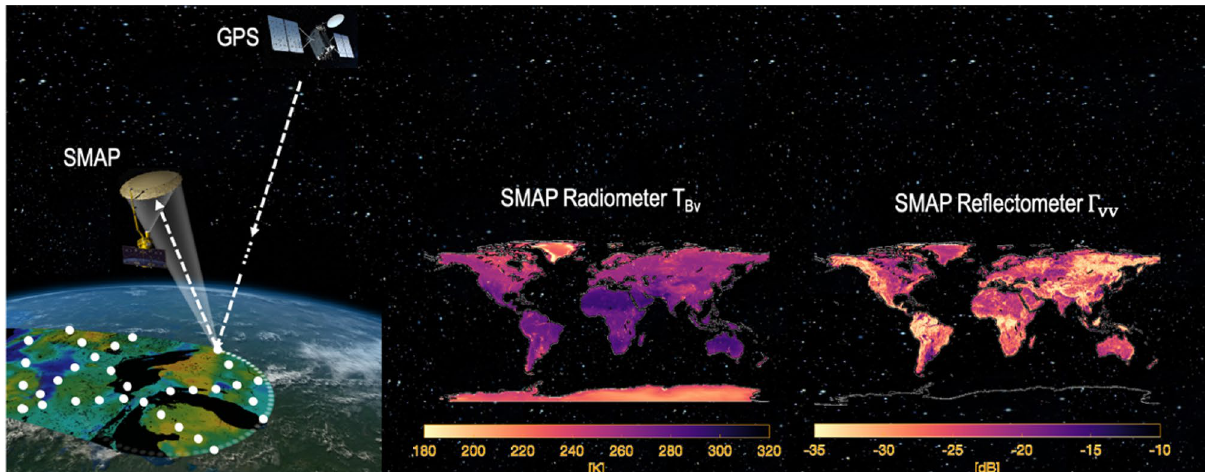
Figure 2. SMAP-Reflectometry—Conceptual sketch of SMAP radiometer and SMAP-Reflectometer measurements while scanning the Earth’s surface, including brightness temperature ( T Bv ) measurements from SMAP radiometer (top-left) and reflectivity ( Ŵ vv ) measurements computed from SMAP-Reflectometer data (bottom-left), gridded at 36 km and 9 km, respectively, for 1 year of data in 2018. Note that Ŵ vv is estimated from the Stokes parameters computed from SMAP-Reflectometer data by assuming negligible cross-polarization. This is further explained in “Methods” section. SMAP Radiometer and SMAP Reflectometer satellite data maps have been created using Matlab R2021b (version 9.11.0.1809720, https:// www. mathw orks. com/ produ cts/ new_ produ cts/ relea se202 1b. html). The Artist’ rendering is modified using Microsoft PowerPoint for Mac version